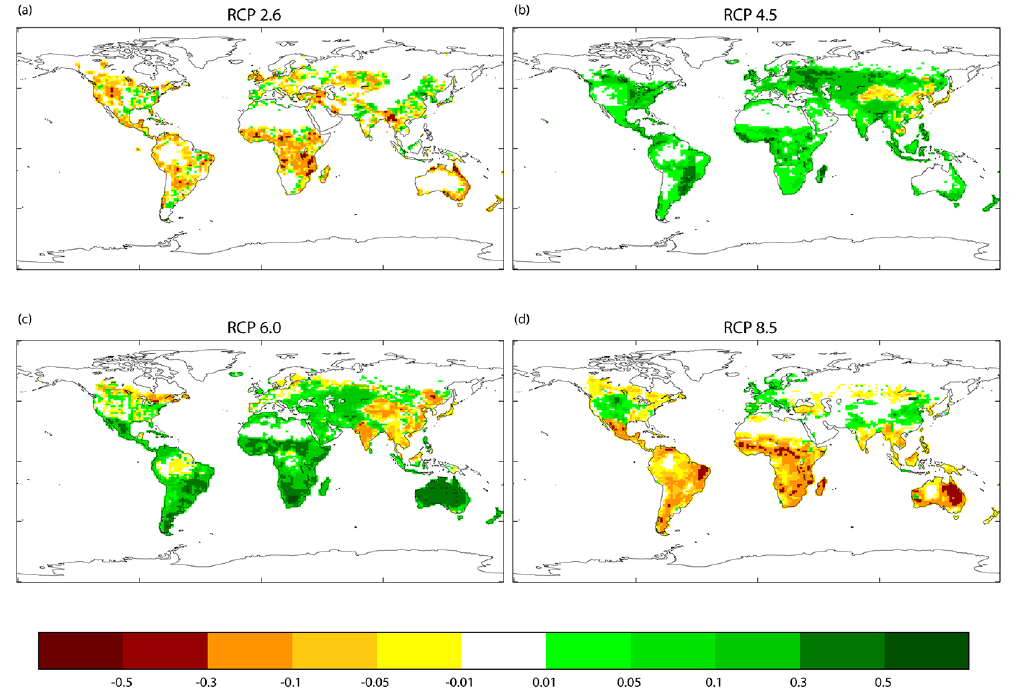
Figure 3. Changes in fraction of land cover disturbed by anthropogenic land use from 2005 to 2100 accompanying (a) RCP2.6, (b) RCP4.5, (c) RCP6.0, (d) RCP8.5, as implemented in HadGEM2-ES following the harmonised land use scenarios of Hurtt et al.